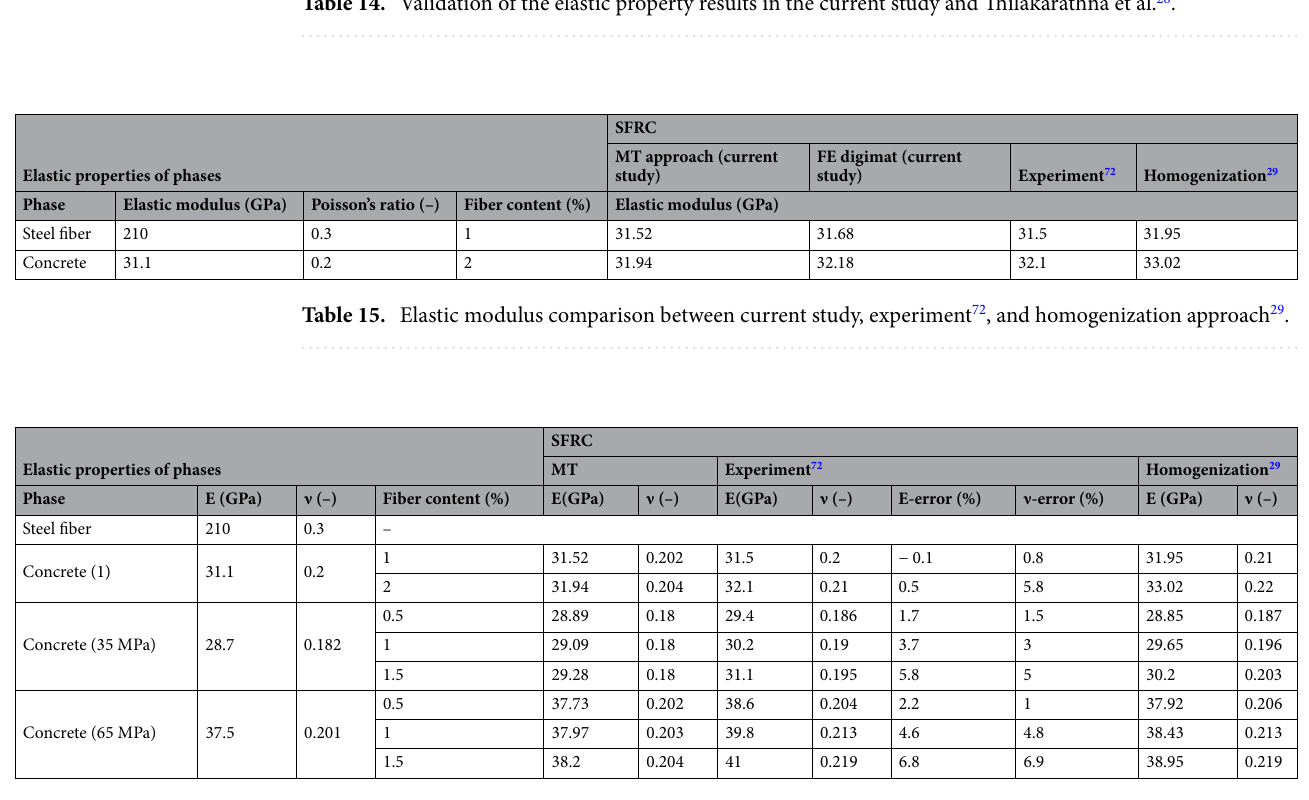
Table 16. Validation of elastic modulus and Poisson’s ratio results for